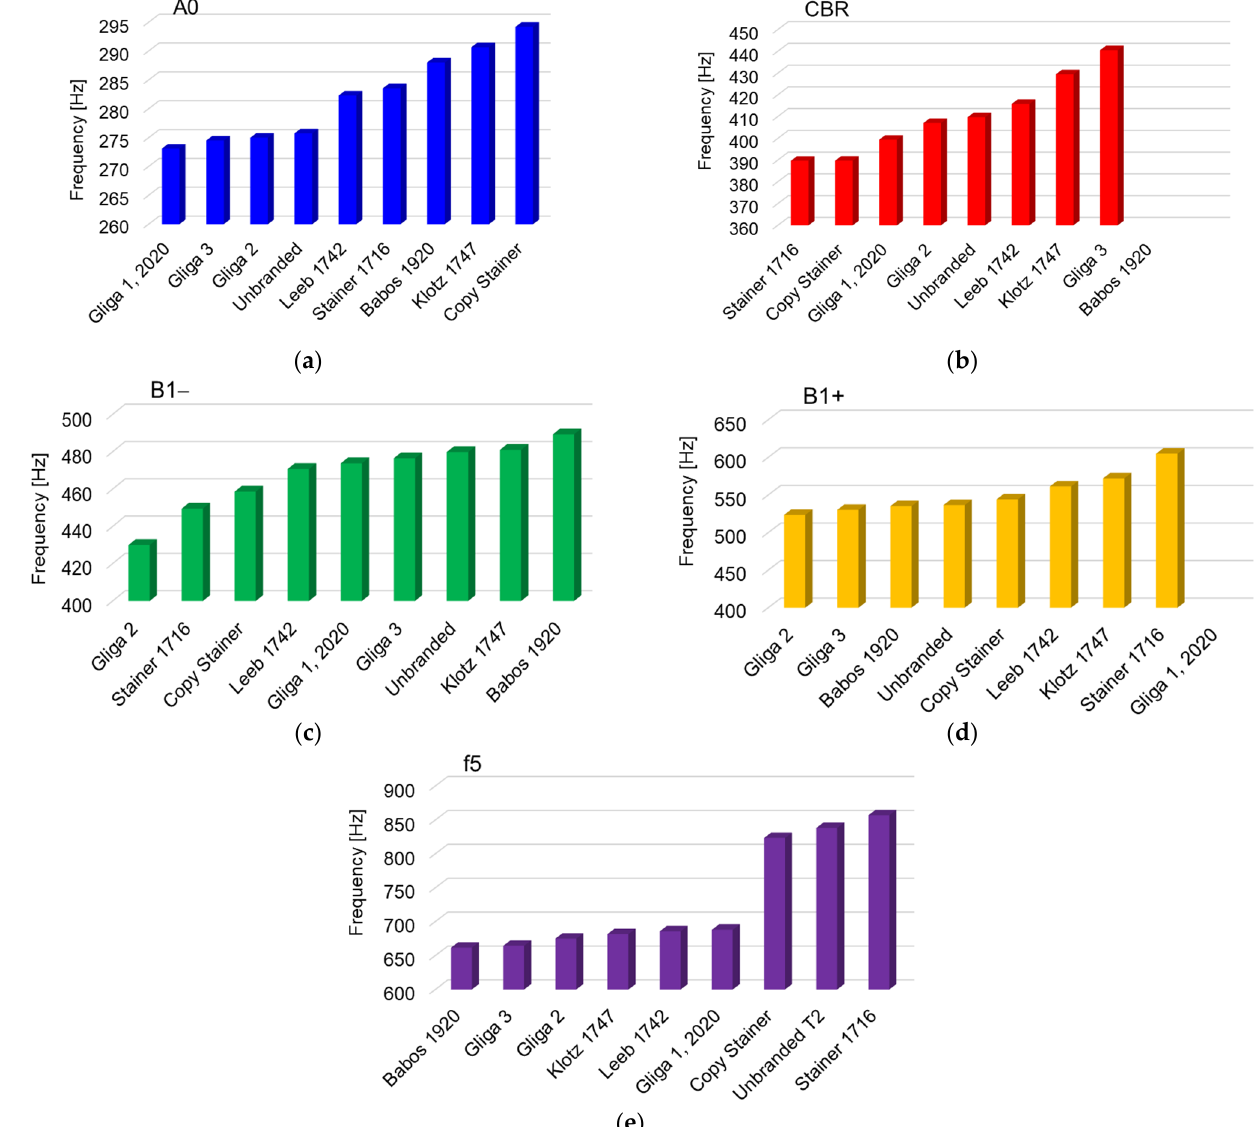
Figure 9. Comparisons between the values of the natural frequencies of the tested violins: ( a ) cavity mode; ( b ) CBR mode; ( c ) B1 − mode; ( d ) B1+ mode; ( e ) the 5th resonance frequency.